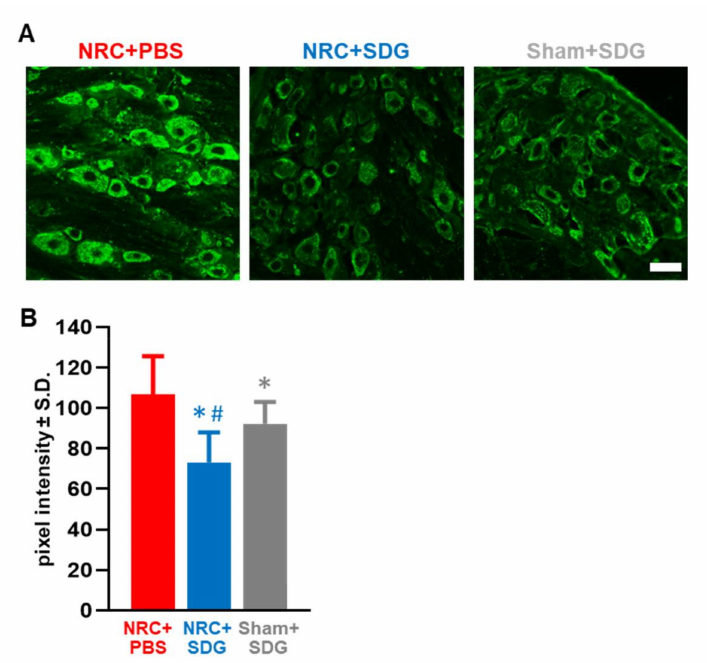
Figure 3. ( A ) Representative images show reduced 8-OHG labeling in the DRG with SDG treatment in rats receiving a painful NRC or sham surgery. The scale bar is 100 µ m and applies to all panels. ( B ) After painful NRC, SDG treatment significantly decreases 8-OHG labeling compared to both NRC with PBS (vehicle) treatment (* p = 0.0001) and levels in the DRGs from Sham + SDG group ( # p = 0.0164). 8-OHG is also significantly lower (* p = 0.041) in the Sham + SDG treatment group compared to the NRC with vehicle treatment.